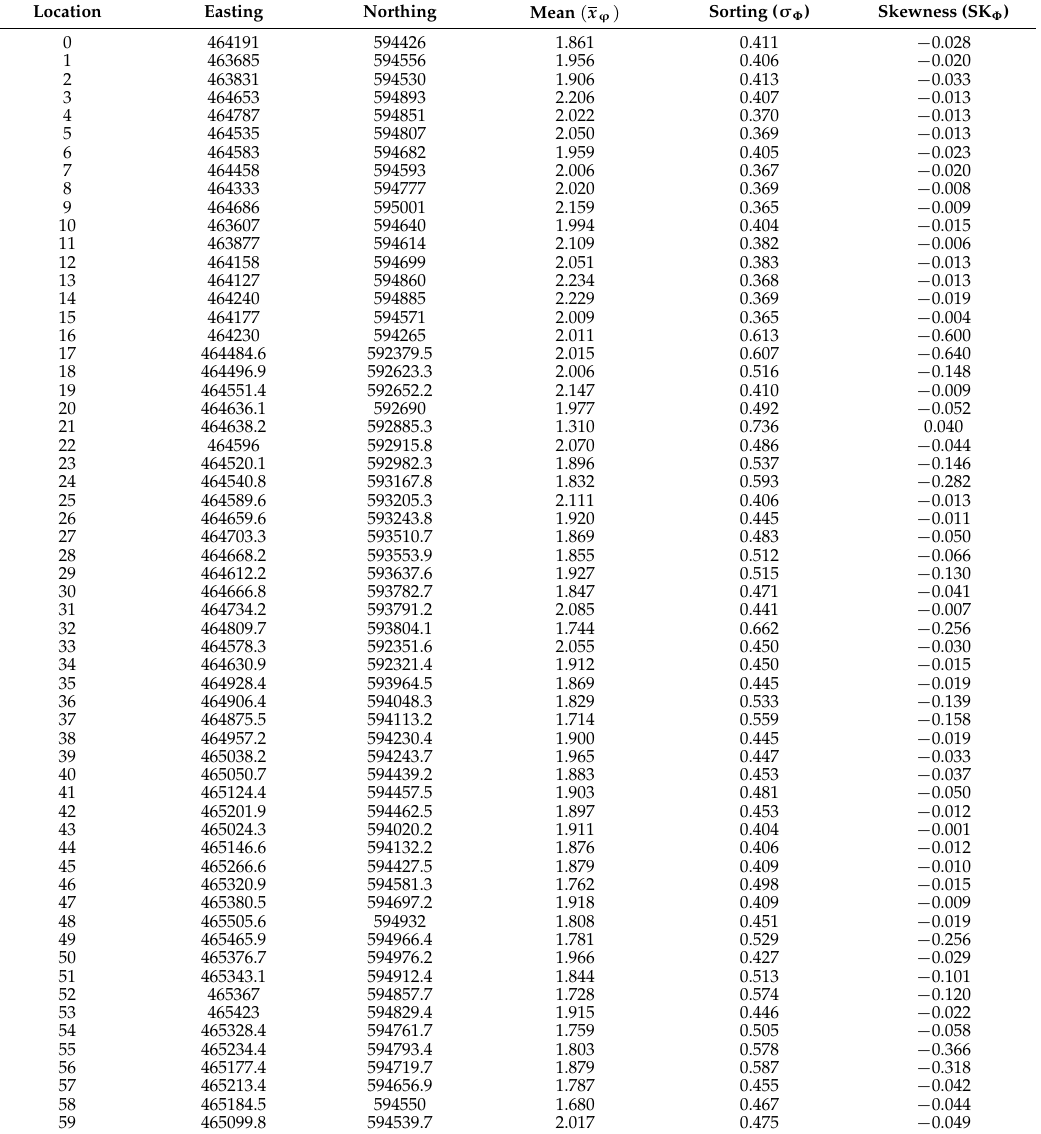
Table 1. Sediment Sample